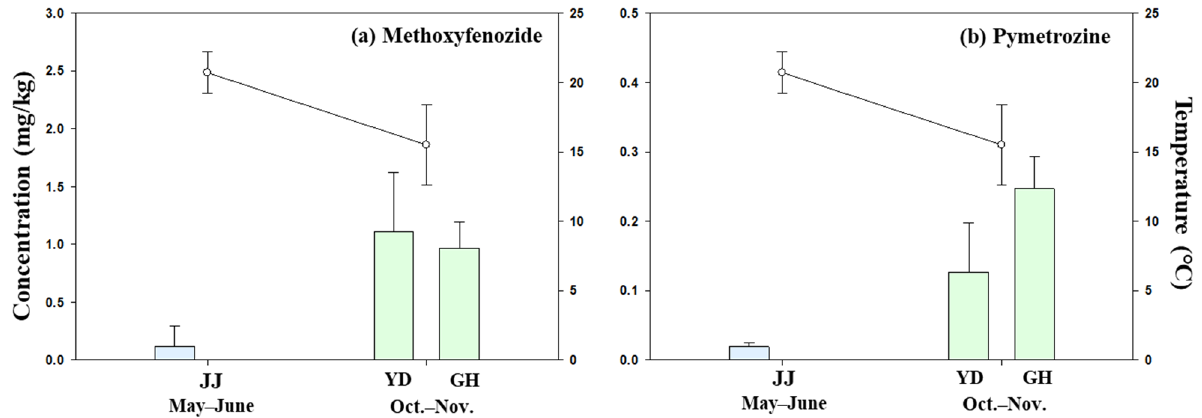
Figure 3. Effects of temperature on residual concentration of ( a ) methoxyfenozide, and ( b ) pymetrozine in Chinese cabbages.